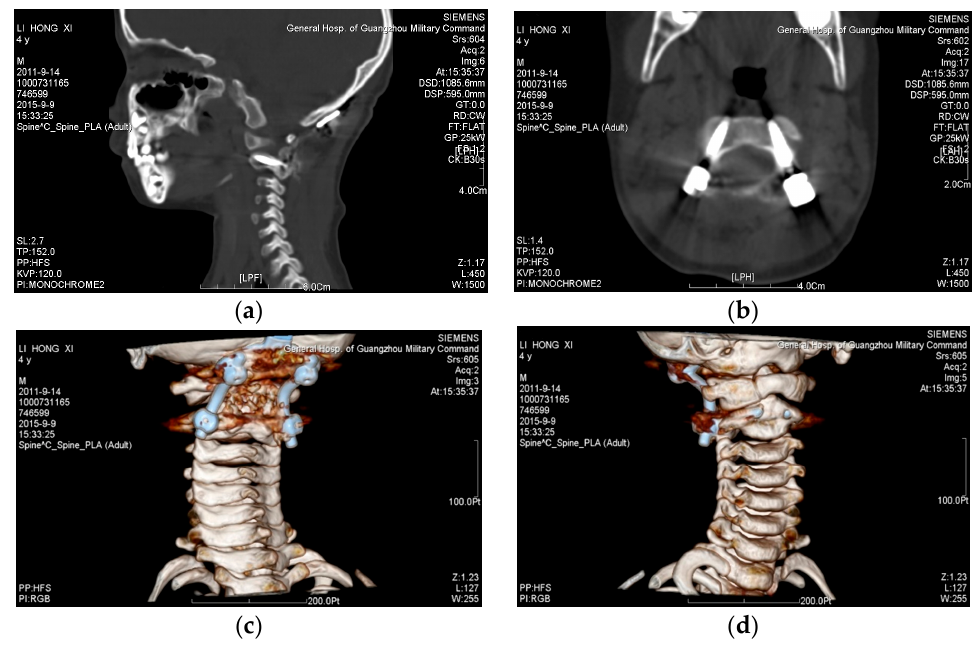
Figure 11. The surgical results observed through the CT reverse engineering method. ( a ) Sagittal view; ( b ) transverse view; ( c ) 3D orientation 1; and ( d ) 3D orientation 2.